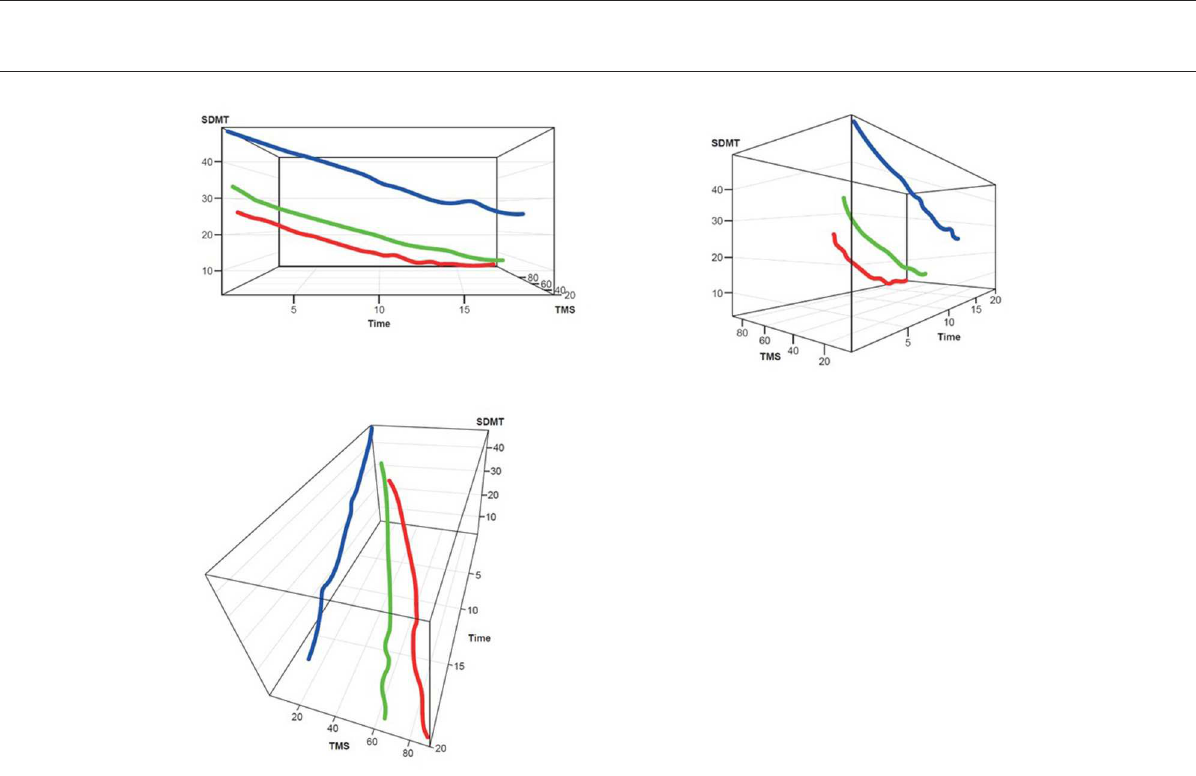
FIGURE3 TMS–SDMT 3D plot for clustering. Red, rapid progressors; Green, moderate progressors; Blue, slow progressors; SDMT, Symbol Digit Modalities Test; TMS, Total Motor Score.